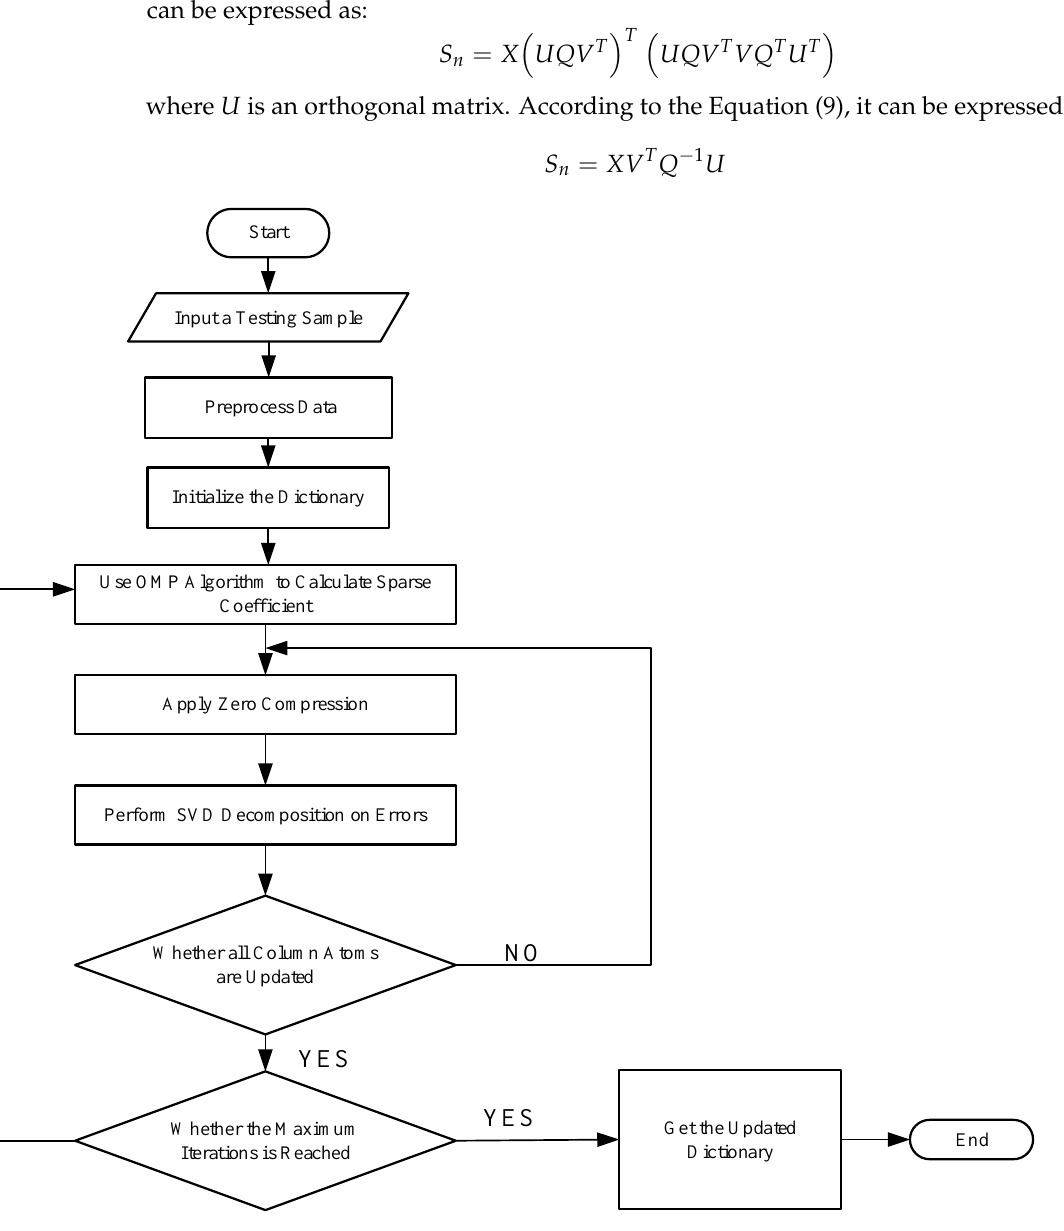
Figure 5. The flowchart of the traditional K-SVD algorithms.